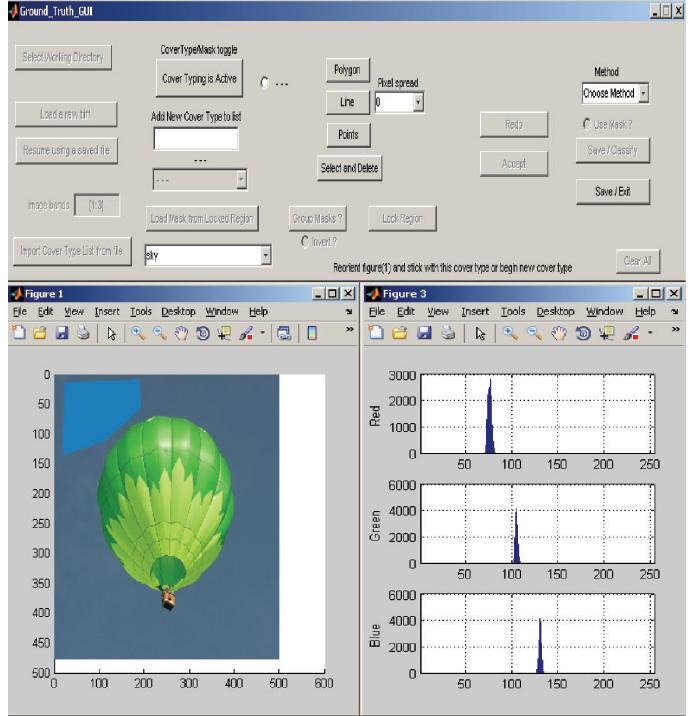
Figure 9. A snapshot of the GUI. On the lower-right are the histograms for each band of the spectral values for the chosen